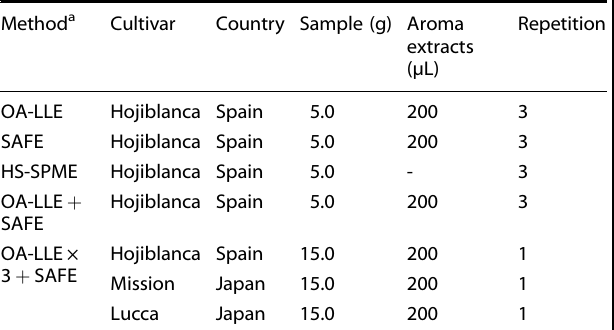
Table 1. Experimental plan for evaluating the extraction ef fi ciency of volatile compounds in EVOO.